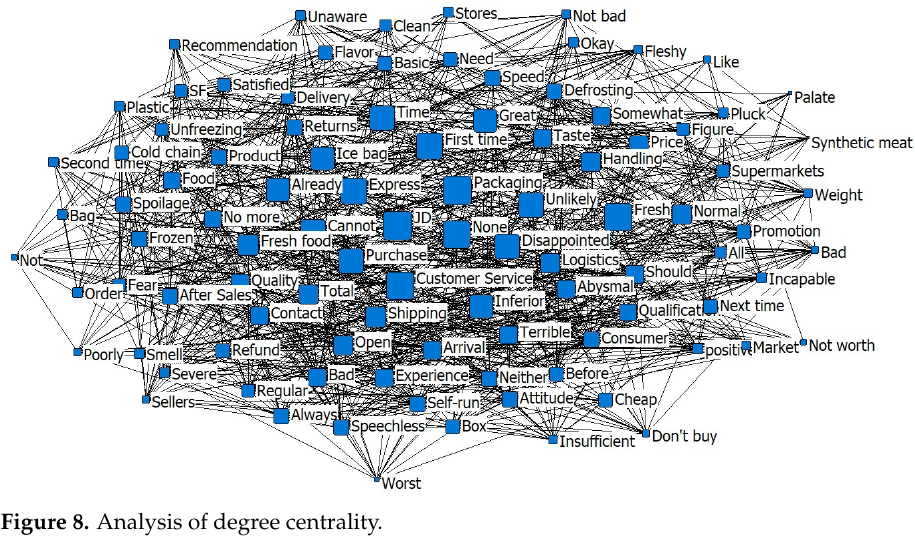
Figure 8. Analysis of degree centrality.